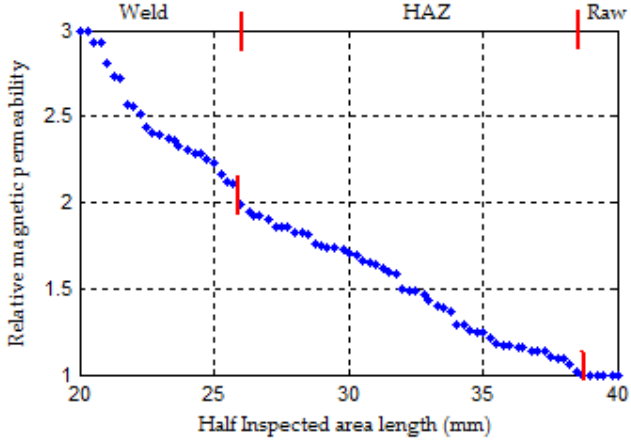
Figure 7. The magnetic relative permeability distribution.